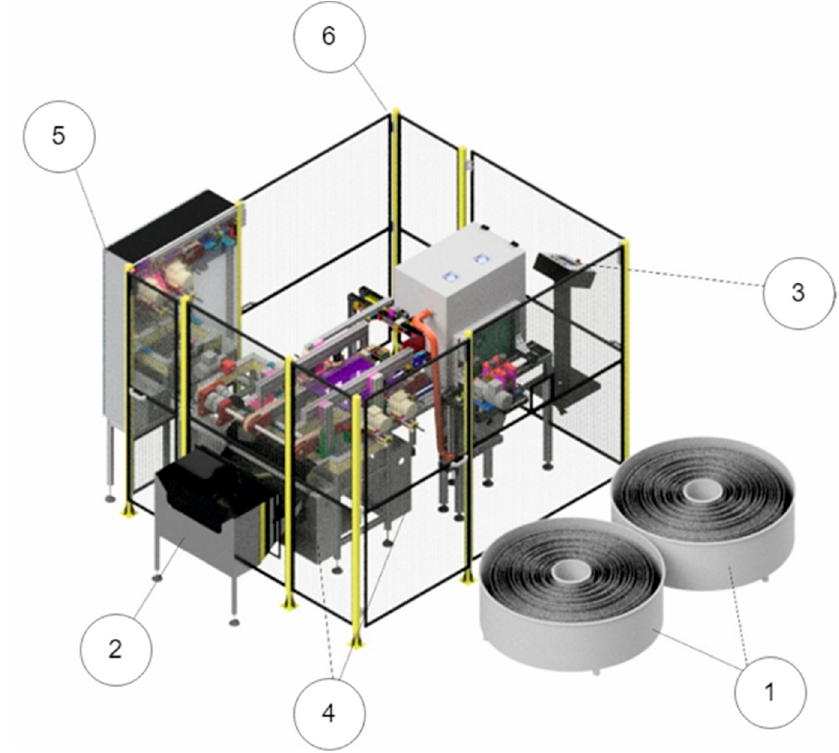
Figure 14. Arrangement of the secondary components in the machine.